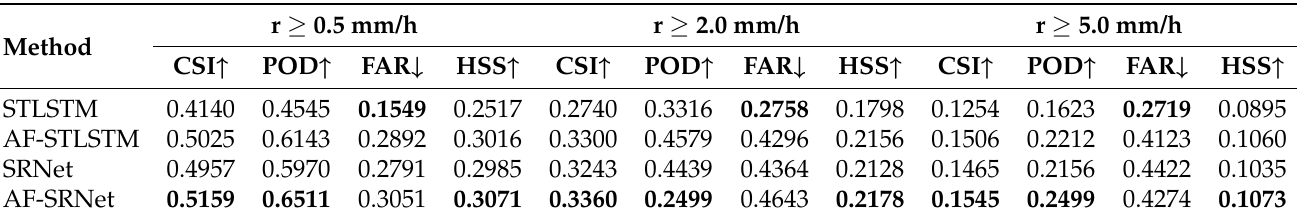
Figure 9. MSE comparison with different time intervals for the next 20 frames, with a 6-min interval between each frame. Table 5. Average evaluation results of one frame of precipitation amount nowcasting in the first hour. The best performance is highlighted in bold. ” ↑ ” means that the higher the score, the better, while “ ↓ ” means that the lower the score, the better.